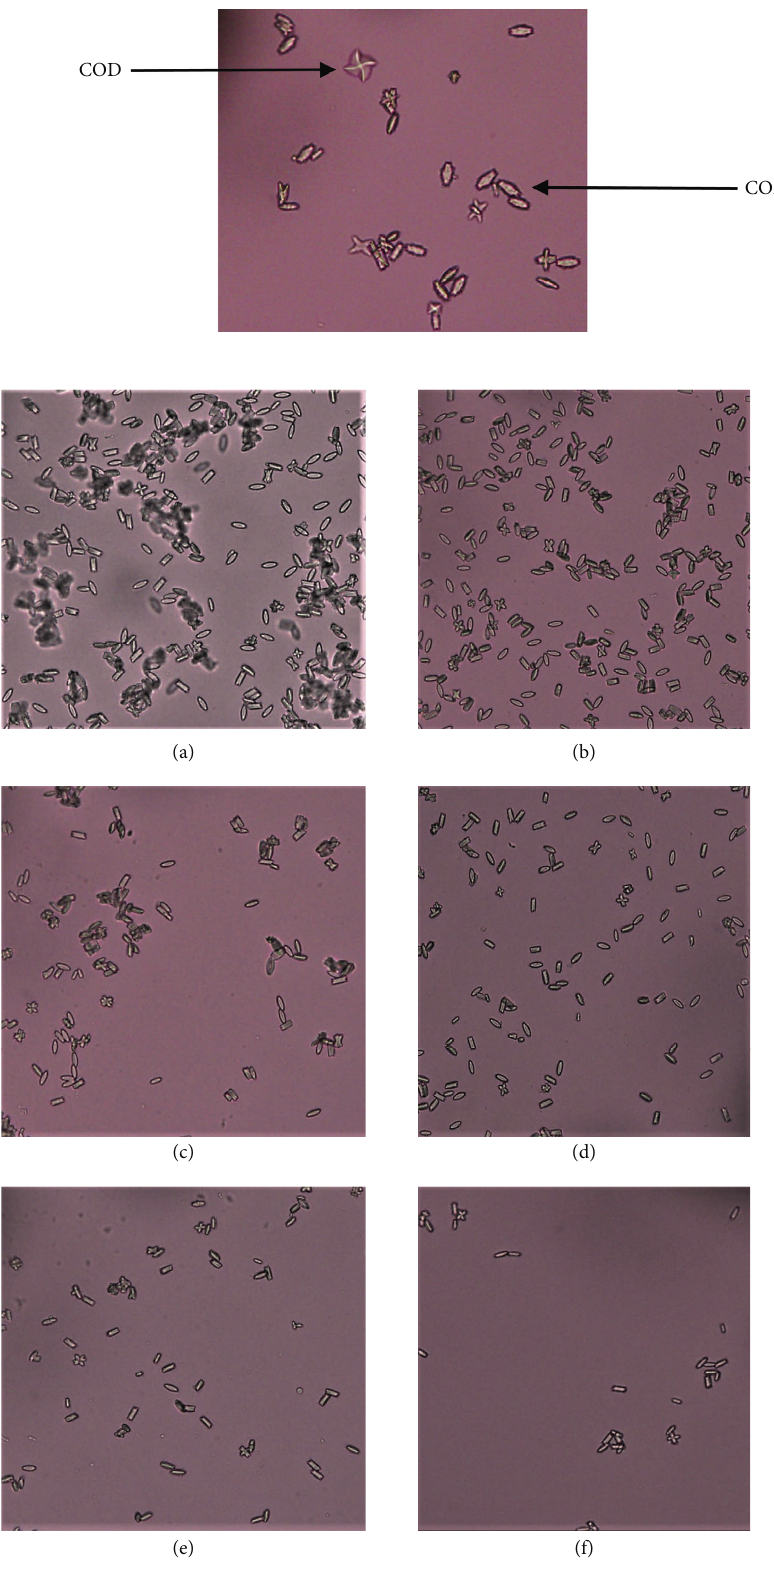
Figure 2: Representative micrographs of calcium oxalate crystals in the nucleation assay as observed under the light microscope (x40 objective) in the absence of the extract (a) and in the presence of ethanol extract of Aegle marmelos (EEAM) 200 μ g/mL (b), 400 μ g/mL (c), 600 μ g/mL (d), 800 μ g/mL (e), and 1000 μ g/mL